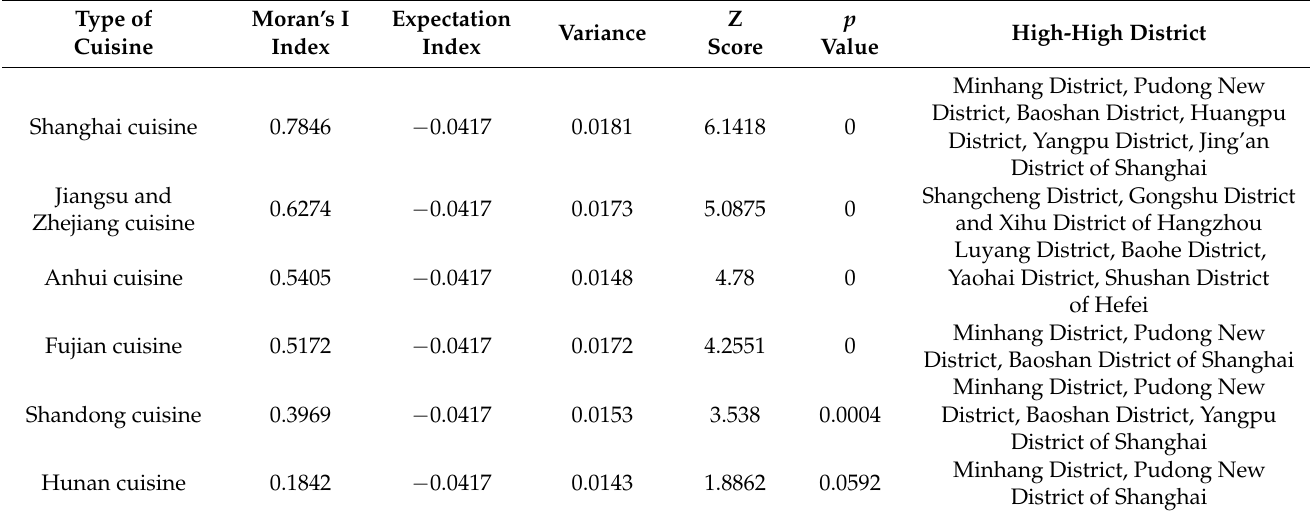
Table 2. Global and local spatial autocorrelation analysis results table of different cuisines in the